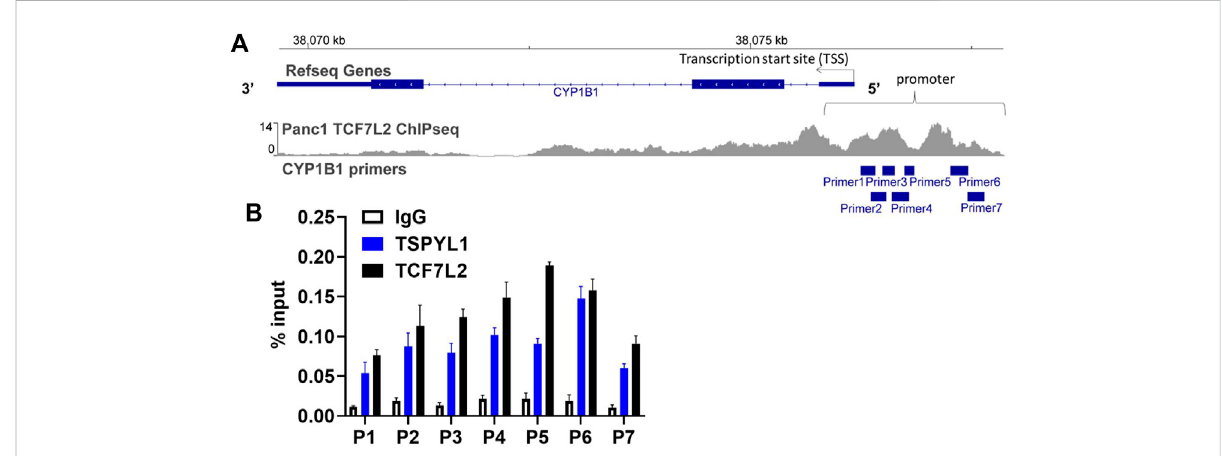
FIGURE 5 TSPYL1 and TCF7L2 bind to the promoter region of CYP1B1 in HepaRG cells. (A) Seven pairs of primers covering the CYP1B1 promoter region were used to perform CHIP assays. (B) CHIP assays were performed to test TSPYL1 and TCF7L2 binding to the CYP1B1 promoter region using HepaRG cells. The binding of TSPYL1 and TCF7L2 to CYP1B1 promoter regions was detected by qRT-PCR and has been expressed as percent of